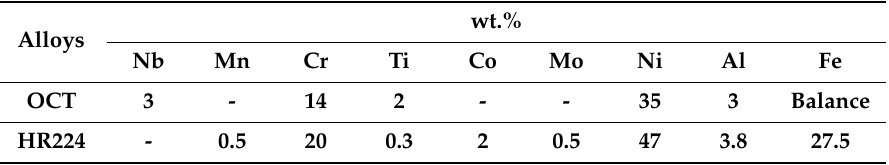
Table 1. Chemical composition of alloys tested.